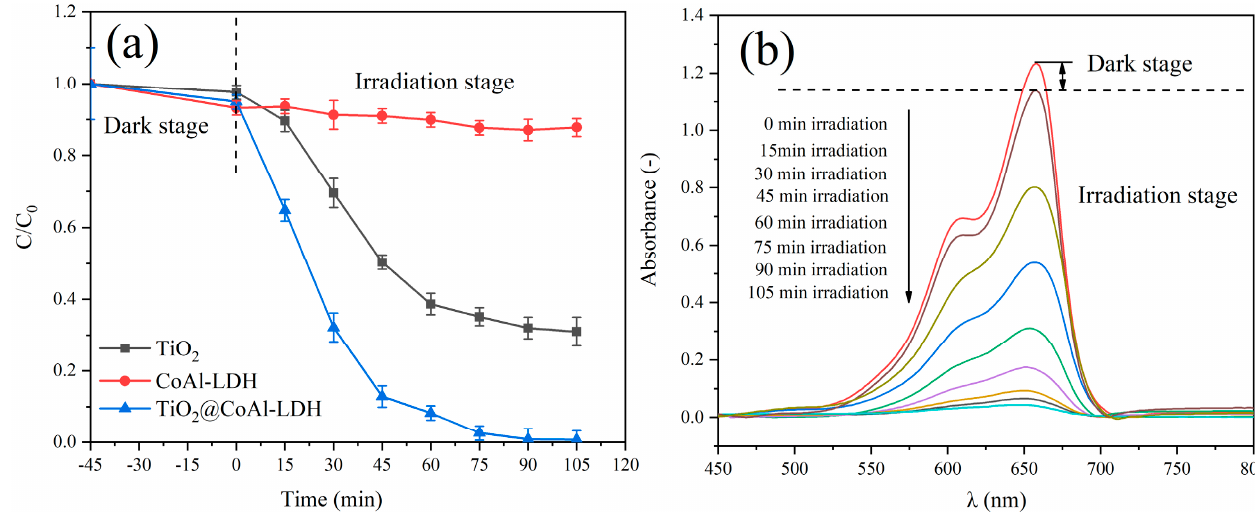
Figure 5. Photocatalytic measurements: ( a ) photocatalytic activity of TiO 2 , CoAl-LDH, and TiO 2 @CoAl-LDH; ( b ) absorbance spectra of MB degradation with UV-visible irradiation time for TiO 2 @CoAl-LDH.